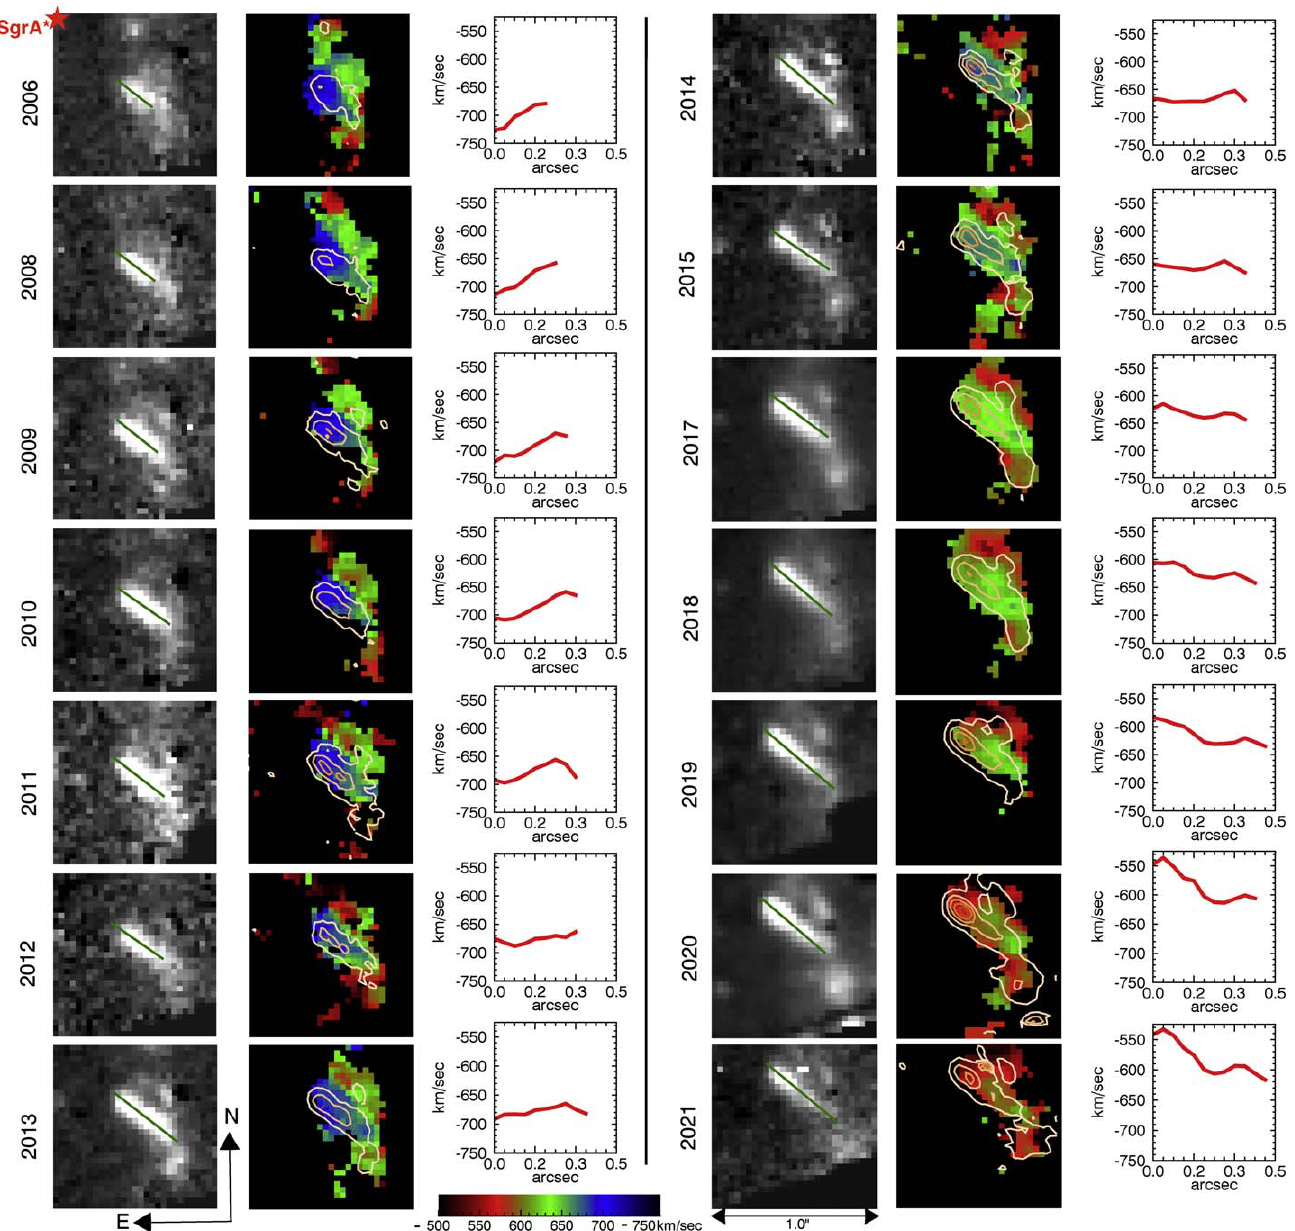
Figure 4. Morphological and dynamical evolution of X7 ʼ s gas emission. Br- γ integrated intensity ( left columns ) and radial velocity for the peak of the local pro fi le ( center columns ) obtained between 2006 and 2021. Br- γ total intensity contours are overlaid on the color-coded velocity maps. Both maps are constructed from a narrow wavelength band centered around the blueshifted Br- γ emission extracted from the OSIRIS data cubes with stellar continua removed. The fi eld shown is a 1 0 × 1 0 area southwest of Sgr A * , positioned so that Sgr A * is located at the upper left corner of each panel. The intensity images illustrate proper motion and morphology evolution of the X7 gas emission, similarly to what Figure 5 shows for the dust emission. The velocity maps highlight the changes in velocity structure, in particular the tip region as it becomes less blueshifted, going from blue ( − 725 ± 15 km s − 1 ) to reddish green ( − 540 ± 15 km s − 1 ) in the color-coded maps over the 15 yr time span. The dramatic changes in the velocity structure of X7 are further demonstrated by the accompanying plots ( right ) of the radial velocity along the X7 ridge as a function of distance from the tip. The position angle of the ridge is highlighted as a green line on the intensity maps and remains relatively constant at 52 ° .4 ± 6 °